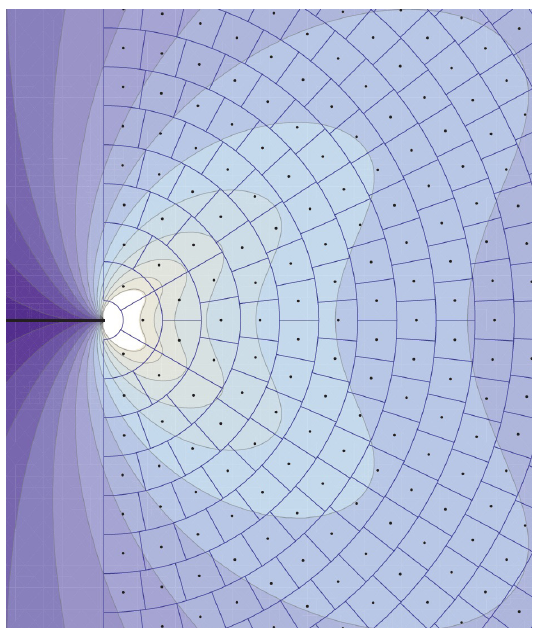
Figure 1. Elements and stress pattern near the crack